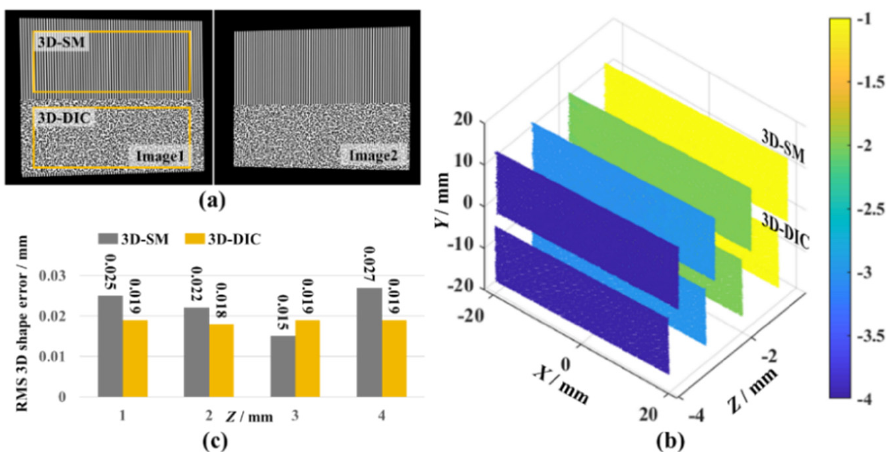
Figure 5. Comparison of 3D shape measured by 3D-SM and 3D-DIC. ( a ) Left and right view of the virtual plane, ( b ) Measurement results of 3D-SM and 3D-DIC, ( c ) RMS 3D shape error of different displacements.